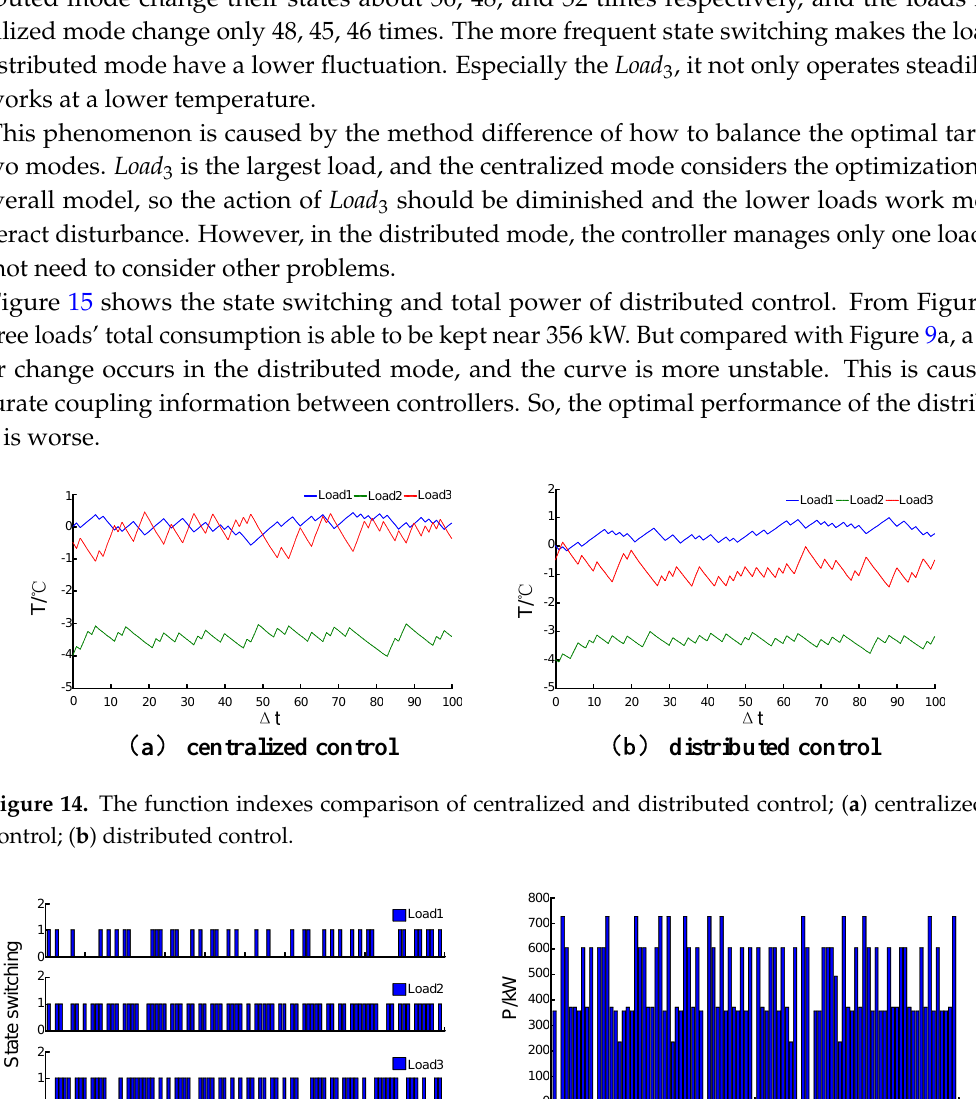
Table 7. The comparison of centralized and distributed control.